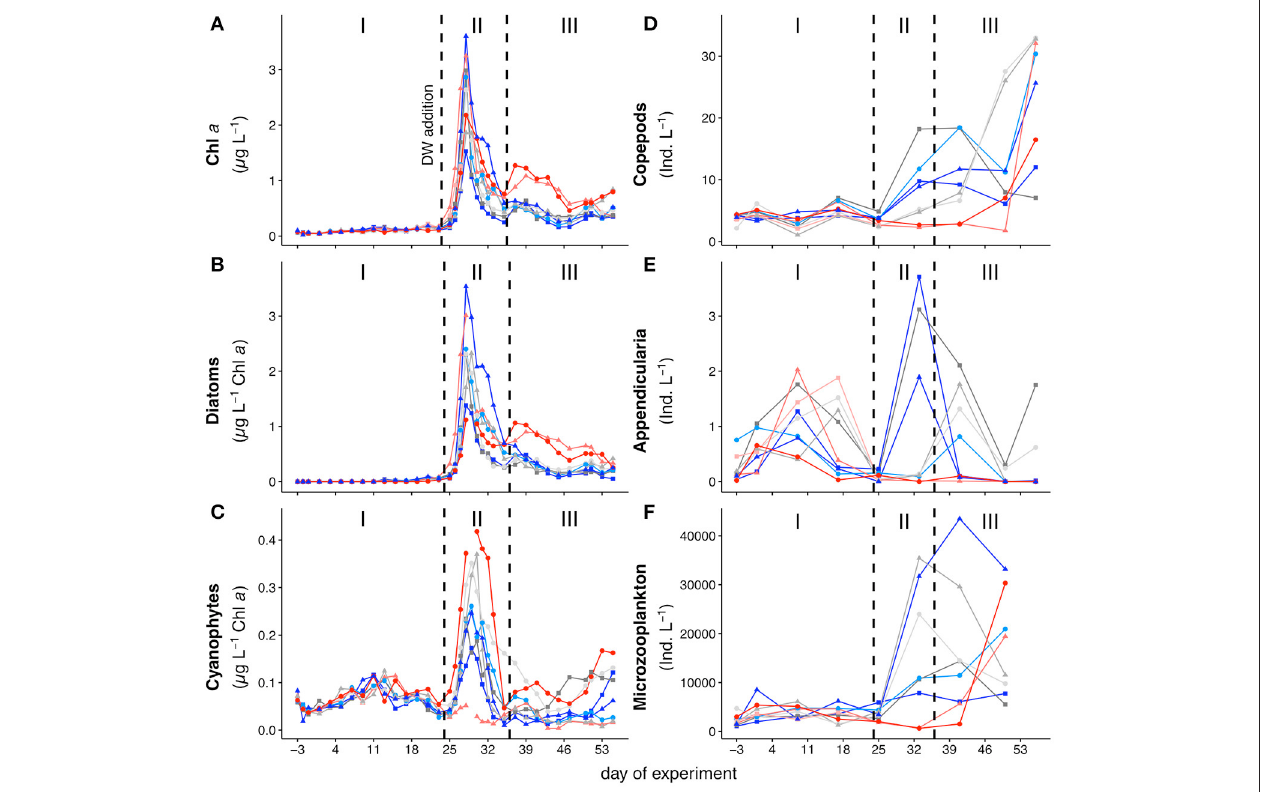
FIGURE 1 | Development of (A) chlorophyll a concentrations. (B) Abundances of diatoms, and (C) abundances of cyanophytes. (D–F) depict zooplankton abundances over the course of the experiment with (B) copepods, including both adult and all copepodite stages, (C) appendicularians, and (D) protozoan microzooplankton, mostly ciliates and heterotrophic dinoflagellates. The three different phases are indicated with I, II and III and separated by the dashed vertical lines. Note that the first dashed line also depicts the time of deep-water addition. Colors and symbols are described in Table 1 .